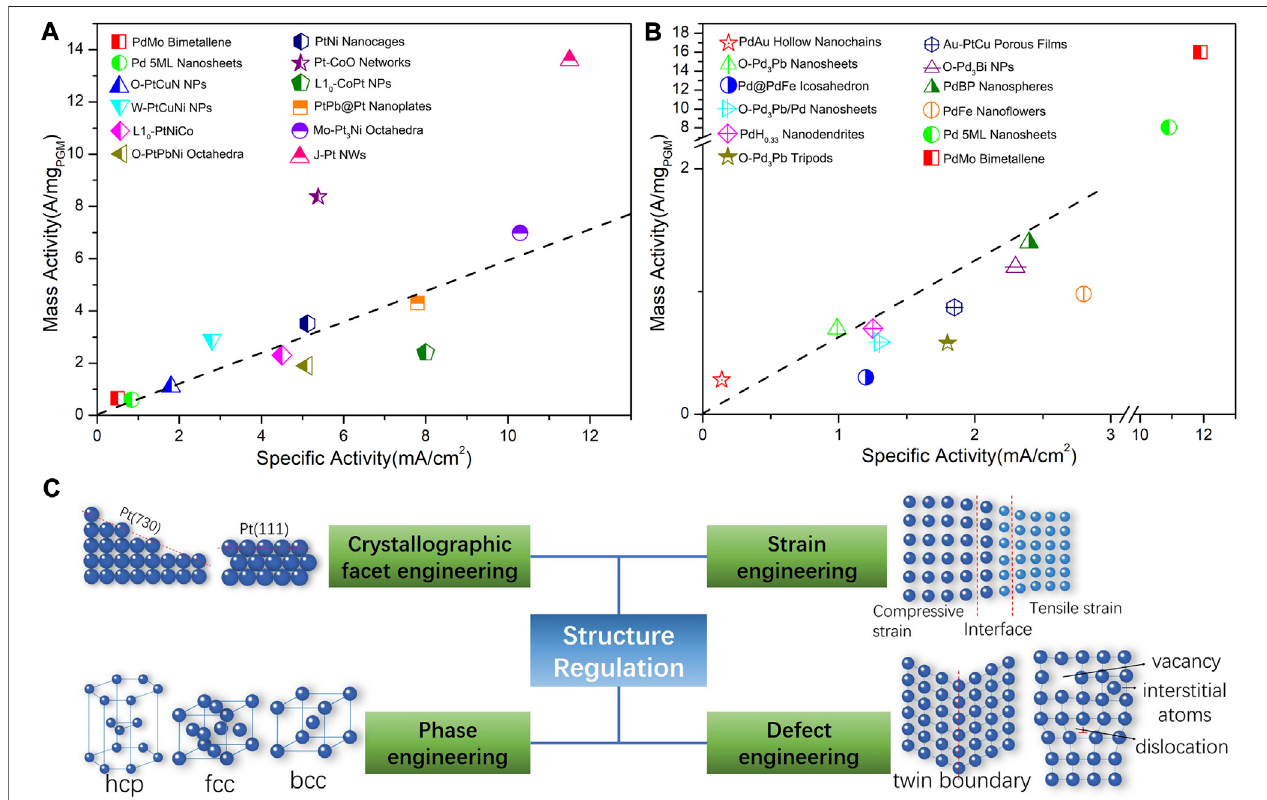
FIGURE1| Currentdevelopmentof platinum-group-metal(PGM)-based nanocatalysts forORRbystructure regulation. (A) Massactivity (MA)and speci fi cactivity (SA) of ORR in 0.1 M HClO 4 . PdMo Bimetallene (Luo et al., 2019); Pd 5 ML Nanosheets (Wang et al., 2019a); O-PtCuN NPs (Zhao et al., 2020); Porous W-PtCuNi NPs (Tu et al., 2019); L10-PtNiCo (Wang et al., 2019c); O-PtPbNi Octahedra (Bu et al., 2017); PtNi Nanocages (Tian et al., 2019); Pt-CoO Networks (Sievers et al., 2020);